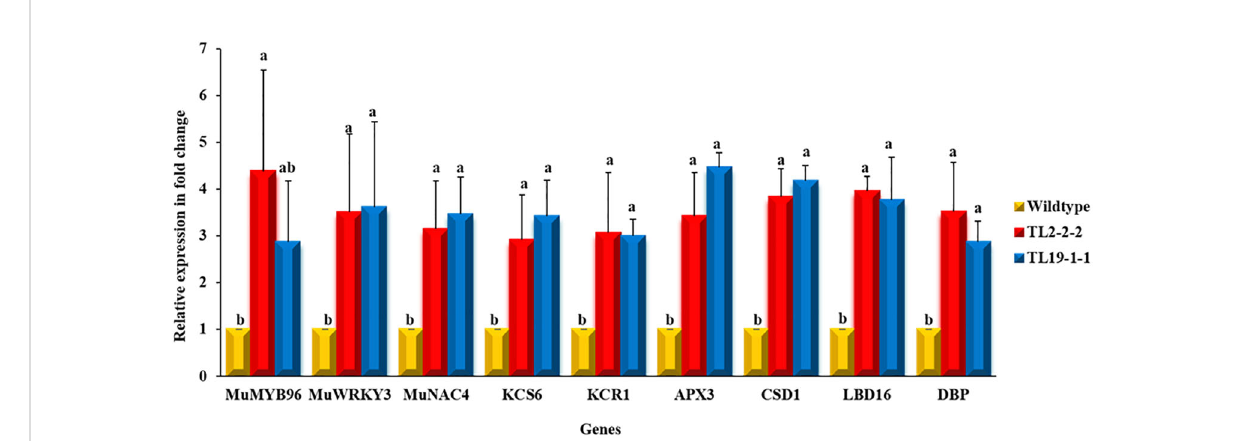
FIGURE 3 Expression pro fi ling of transgenes and downstream genes using qRT-PCR: The leaf samples of multigene groundnut transgenic plants and wild type subjected to drought stress were used for gene expression analysis. Bars represents mean of three biological samples and error bars depicts the standard error and different alphabets represent statistically signi fi cant difference with P ≤